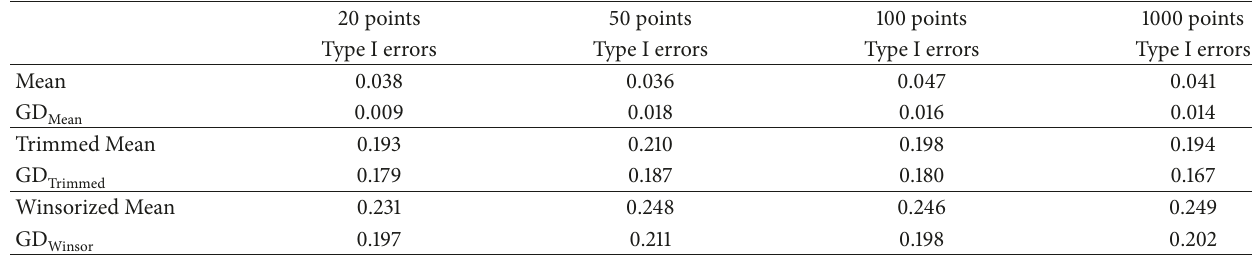
Table 12: Log-normal distributions with 30% noise